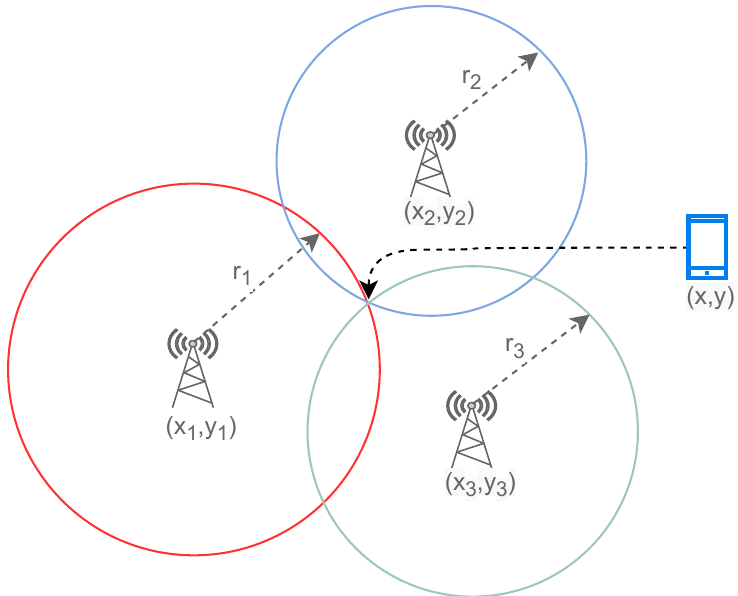
Figure 3. Trilateration used by GPS